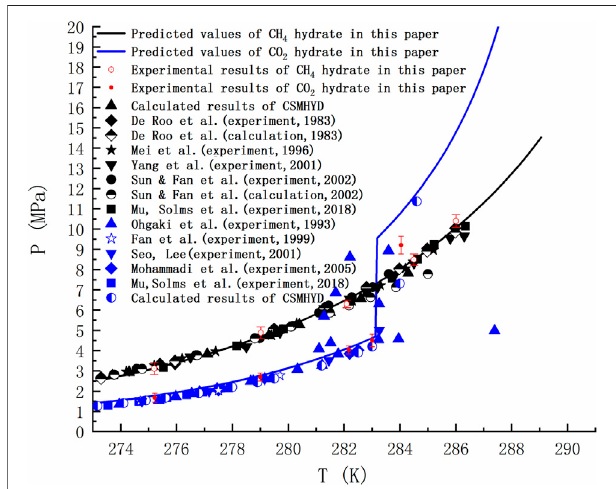
FIGURE 2 | Comparison of predicted phase equilibrium curves of pure CH 4 hydrate and CO 2 hydrate with literature values (De Roo et al., 1983; Ohgaki et al., 1993; Mei et al., 1996; Fan and Guo, 1999; Seo et al., 2001;